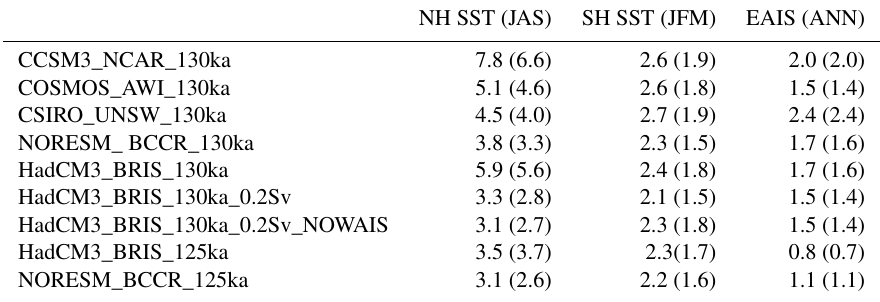
Table 2. Root mean squared error (RMSE) for NH and SH SSTs and East Antarctic Ice Sheet (EAIS) near-surface air temperature regions. RMSE is calculated according to Eq. (1) (RMSE 1 ) and Eq. (2) (RMSE 2 , values in brackets). The model output is compared with the 130 and 125ka time slices from Capron et al. (2014). Note that the simulations without freshwater forcing included were previously described in Lunt et al. (2013) and references therein. JAS: July–August–September; JFM: January–February–March; ANN: annual